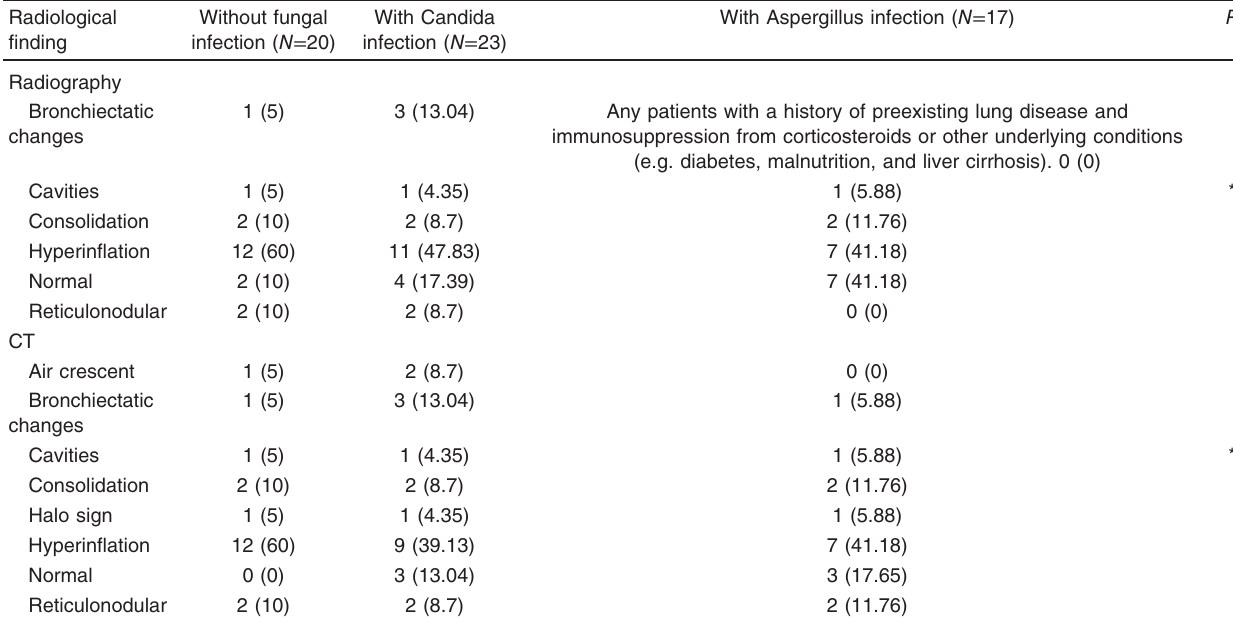
With Aspergillus infection ( N = 17) P